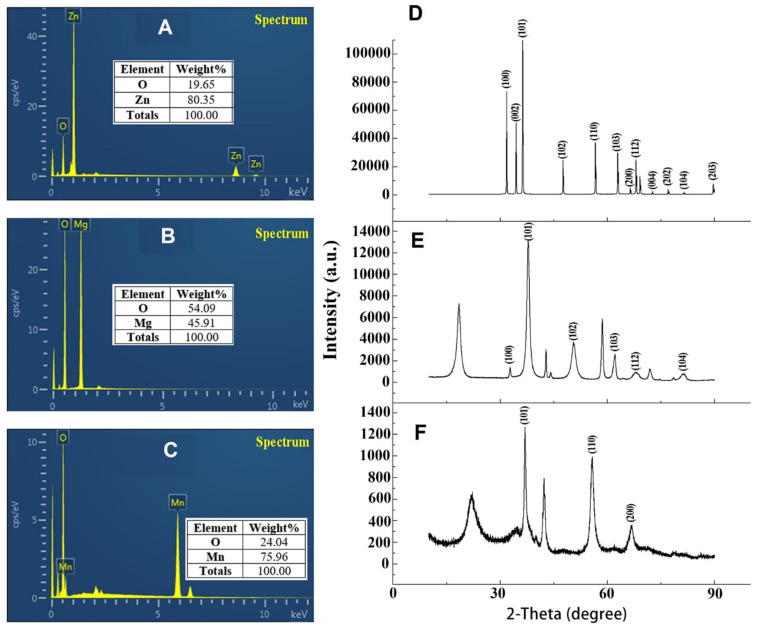
Energy dispersive spectrum profiles of (A) ZnO nanoparticles (B) MgO nanoparticles (C) MnO2 nanoparticles and X-ray Diffractometer spectra of (D) ZnO nanoparticles (E) MgO nanoparticles (F) MnO2 nanoparticles.